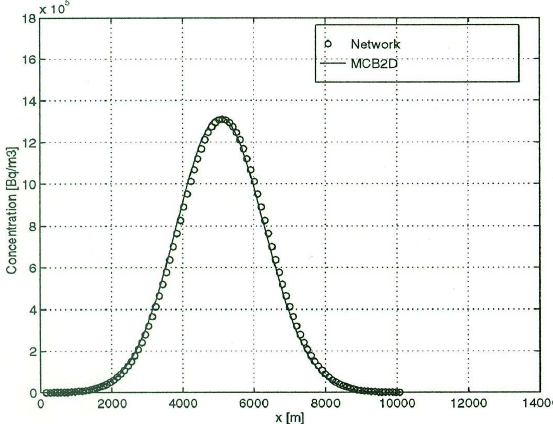
Fig. 4.7. Network 3, v/R=1.3 (cid:215) 10 -3 m/d, e